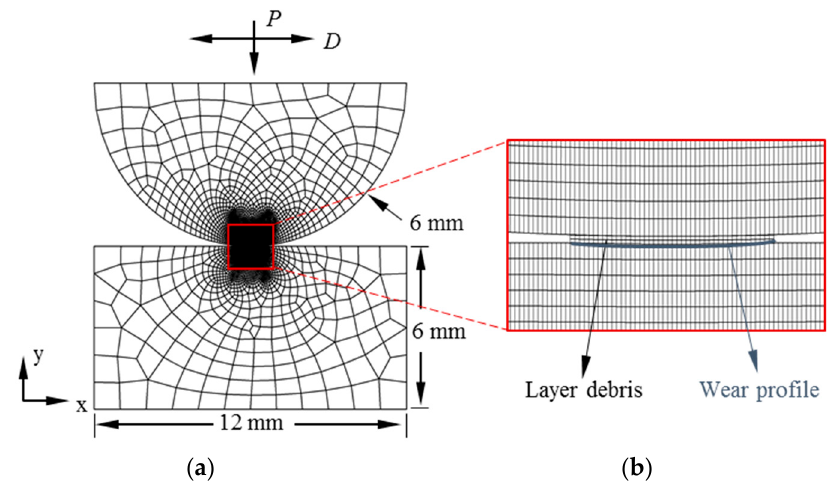
Figure 1. The fretting wear model with debris layer: ( a ) global scale with dimensions and ( b ) local configuration at the contact zone.